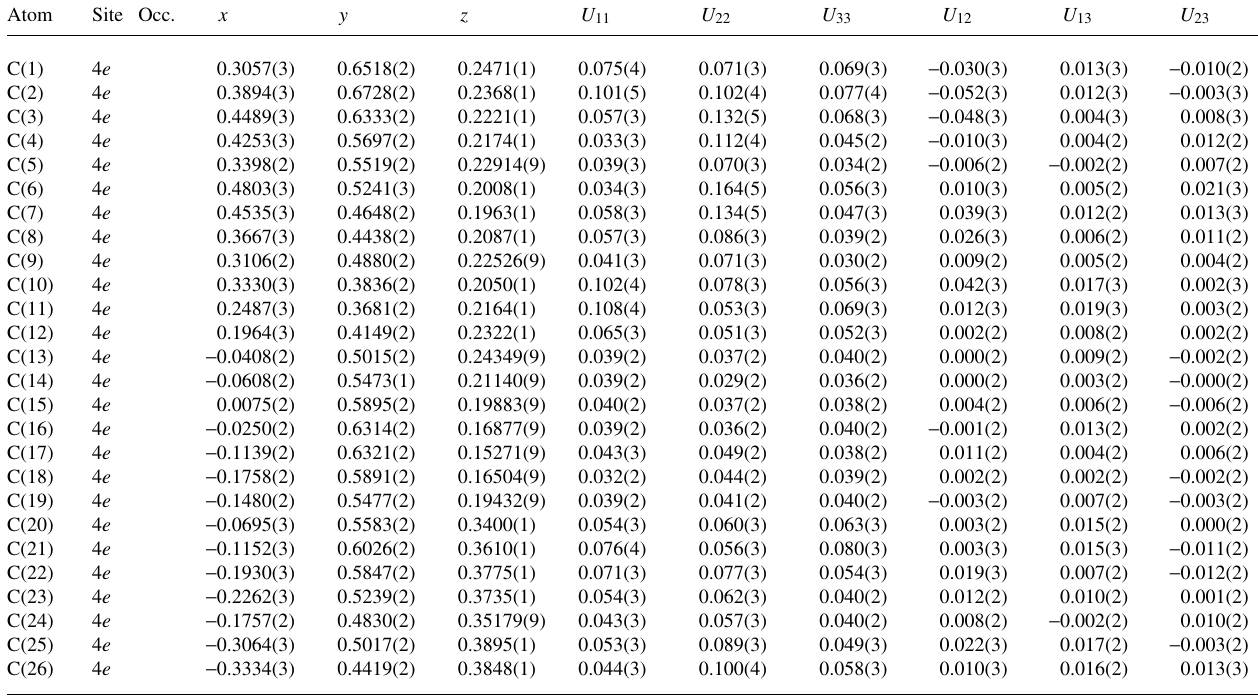
Table 3. Atomic coordinates and displacement parameters (in Å 2 ) .